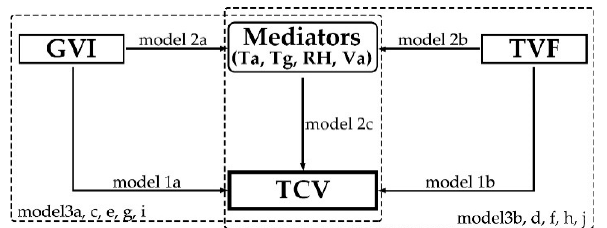
Figure 5. The models in mediation analysis.